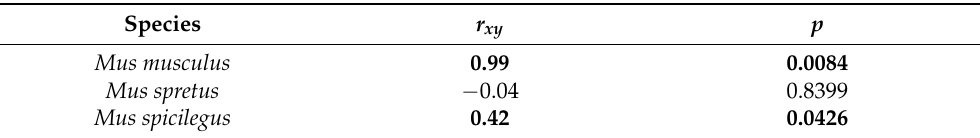
Table 2. Pearson correlations between percentages of capacitated sperm and of hyperactivated sperm under capacitating conditions (mT-BH medium) in three mouse species ( M. musculus , M. spretus , and M. spicilegus ). Results in bold indicate significant differences ( p < 0.05) in statistical analyses. Species r xy p Mus musculus 0.99 0.0084 Mus spretus − 0.04 0.8399 Mus spicilegus 0.42 0.0426